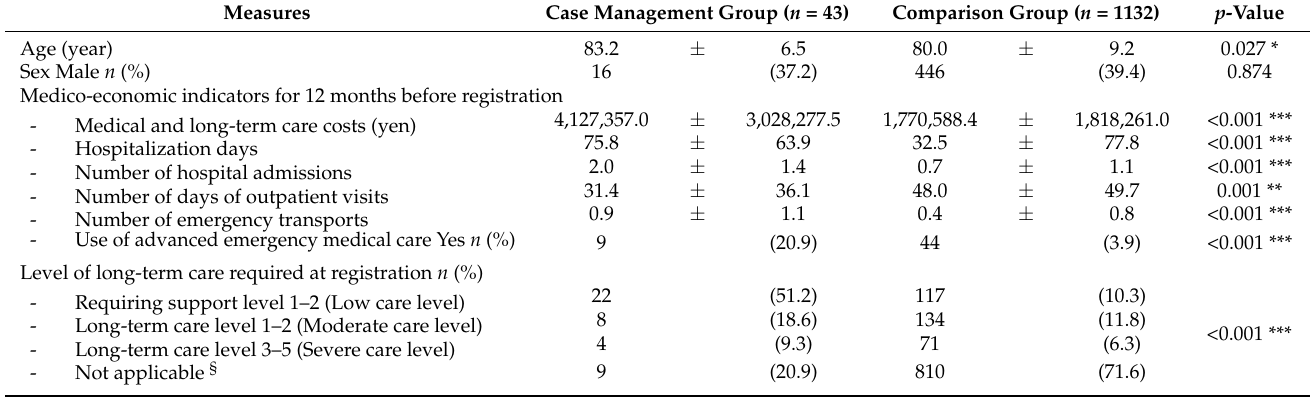
Figure 1. Flow chart of participant selection. Table 1. Comparison of the two groups before propensity score matching. Mean ± Standard